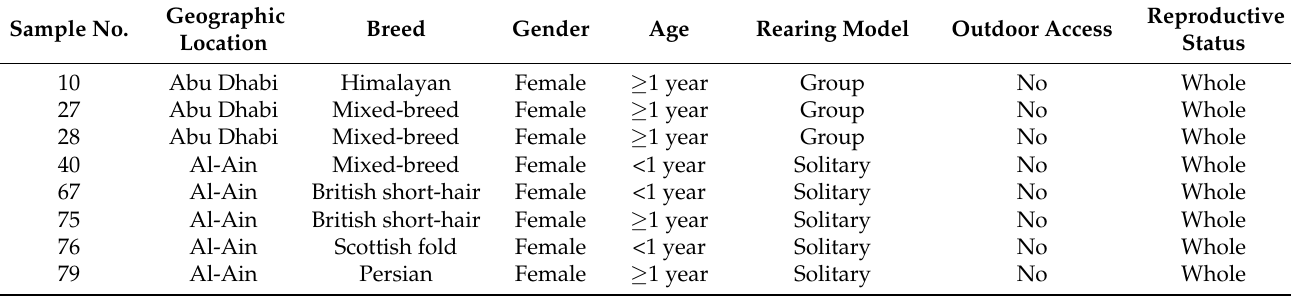
Figure 2. ( A ) Prevalence of feline coronavirus (FCoV) in cats (all cats, mixed-breed cats, and purebred cats). ( B ) Prevalence of feline coronavirus (FCoV) in different purebred cats (British short hair, Himalayan, Scottish fold, Turkish Angora, Persian, and Siamese). * statistically significant difference ( p ≤ 0.05). Table 3. Details of the eight cats’ sera showed SARS-CoV-2 positive